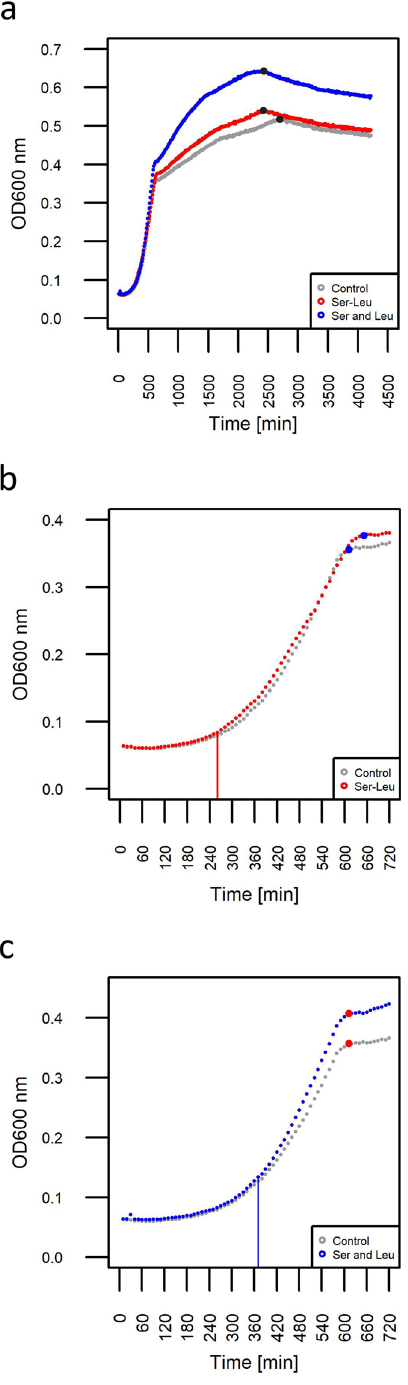
Fig. 8 Analysis of YSBN2 growth response to Ser-Leu supplementation. a YSBN2 strain was supplemented with 1 mM Ser-Leu or mixture of 1 mM serine and 1 mM leucine (Supplementary Data S31). Growth was monitored by measuring the optical density at 600 nm wavelength for 75 h using an automatically recording incubator. Data represent the means n = 3. Black dot represents end of respiration phase. b Cropped growth curve of YSBN2 supplemented with Ser-Leu (0 – 12 h). Blue dot represents diauxic shift. Red, straight line indicates beginning of Ser-Leu treatment effect on yeast growth. c Cropped growth curve of YSBN2 supplemented with Ser and Leu (0 – 12 h). Red dot represents diauxic shift. Blue, straight line indicates beginning of Ser and Leu treatment effect on yeast